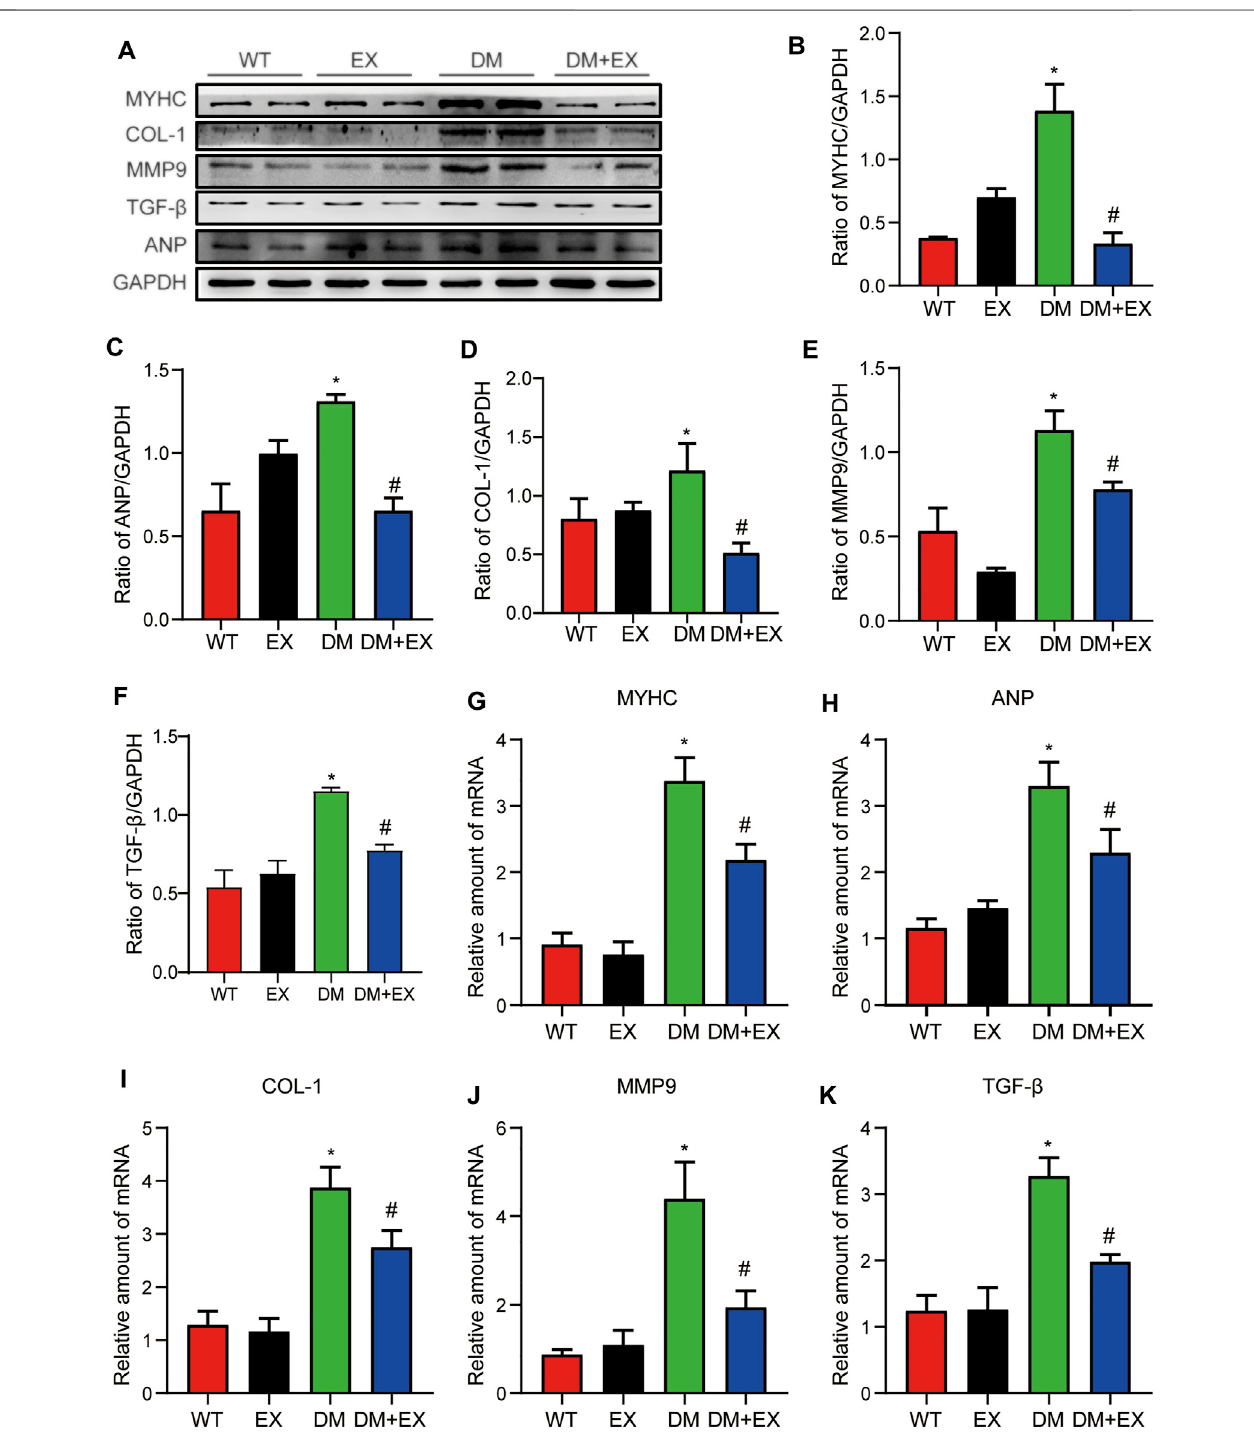
FIGURE 7 | Exercise weakened myocardial remodeling in diabetic mice. (A – F) Protein expression of fi brotic markers and hypertrophy in myocardial tissue and Statistical Graph. (G – K) Gene expression of myocardial hypertrophic markers and fi brosis in myocardial tissue. * p < 0.05 vs. the WT group, # p < 0.05 vs. the db/db